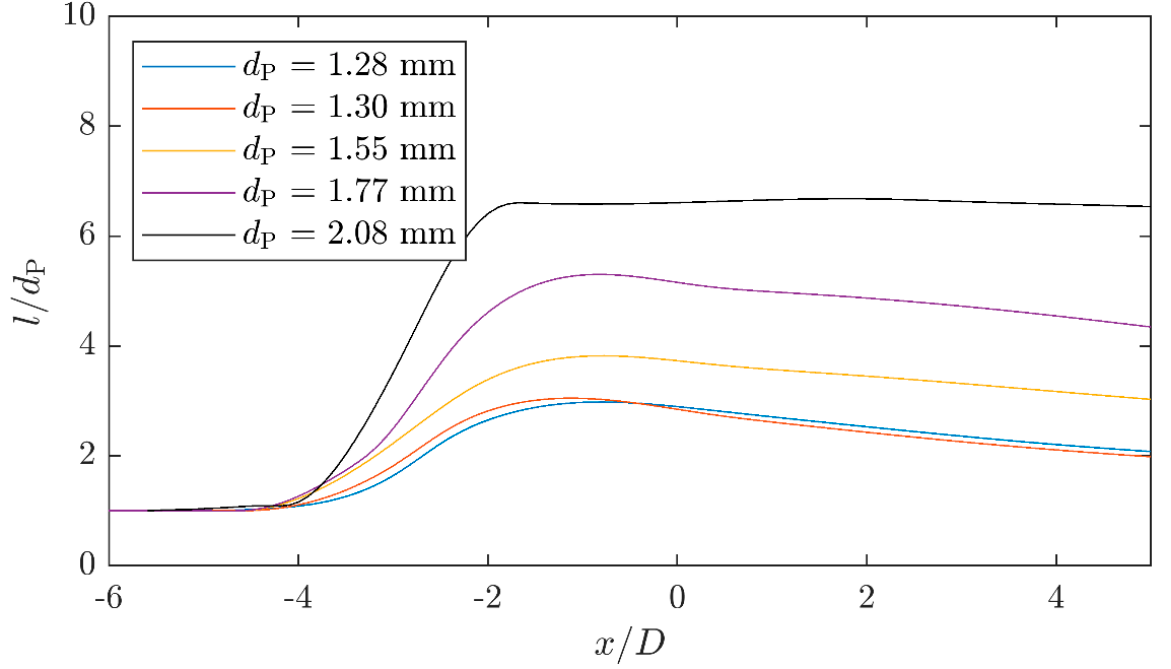
Figure 19. Dimensionless elongation curves for different initial drop diameters ( d P ) at λ = 3.0 and Re = 2000 .